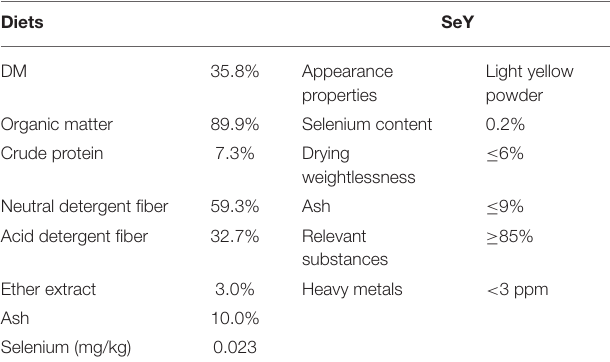
TABLE 1 | The chemical contents of diets [as dry matter (DM) basis] and selenium-enriched yeast (SeY) specific